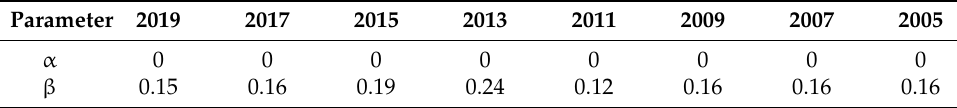
Table 4. Calculation parameters of NEVI from 2005 to 2019.